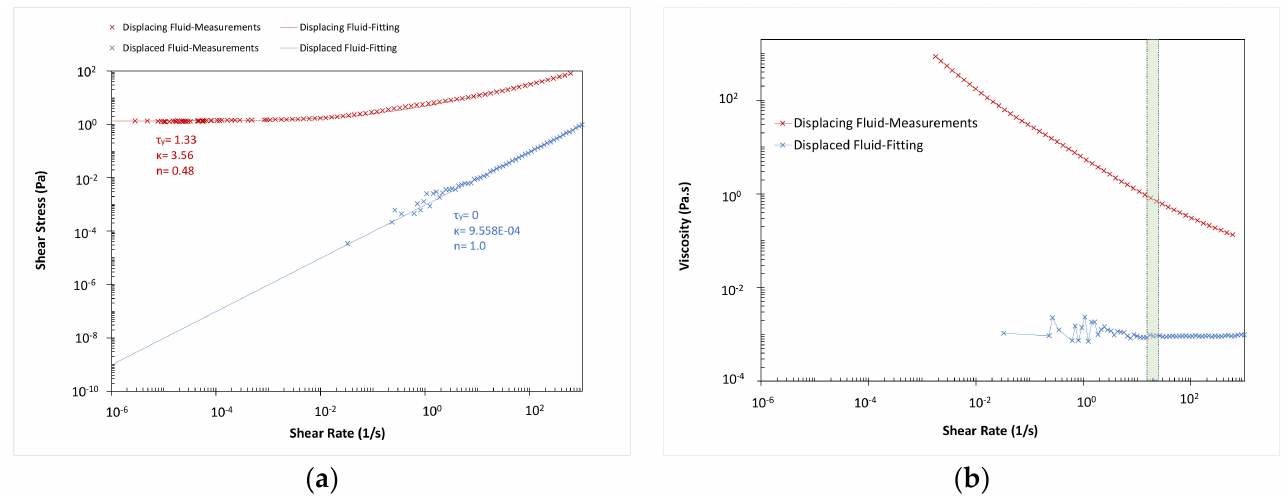
Figure 6. Rheological behavior of the displaced and displacing fluids in tests no. 3, 4, and 5. ( a ) Flow curve; ( b ) equivalent